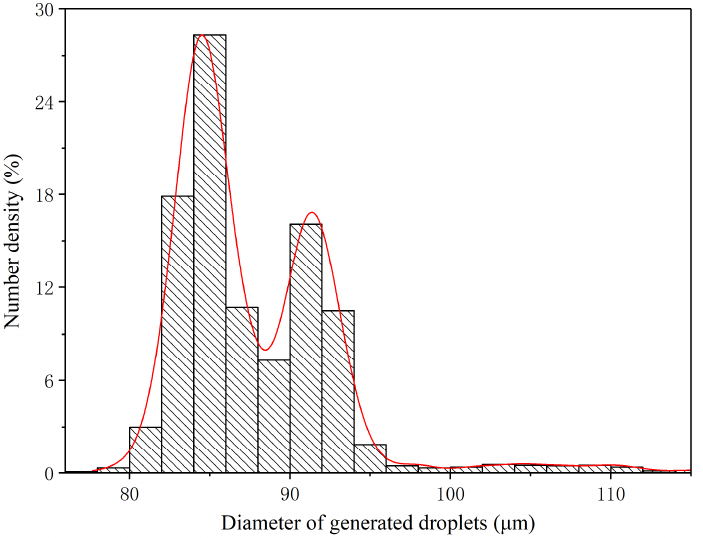
Figure 9. Size distribution of generated monodisperse droplets under OC1 ( q = 20 mL/h, f = 20 kHz).